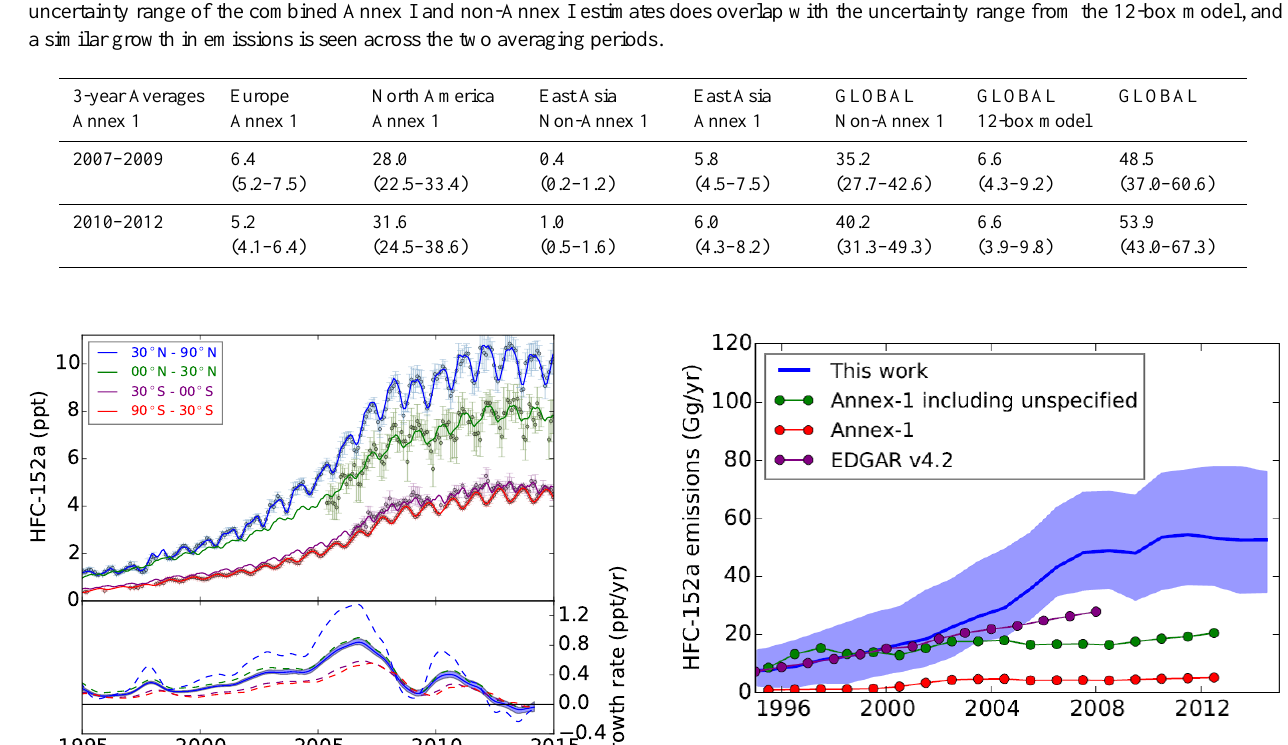
Figure 7. HFC-152a emissions estimates derived from observations (blue line and shading, 1 σ uncertainty) and inventories. The purple line shows the global emissions estimates from EDGAR (v4.2), the red line shows the emissions reported to the UNFCCC and the green line shows emissions calculated from all data reported to UNFCCC, including allowance for the HFC-152a component of unspecified